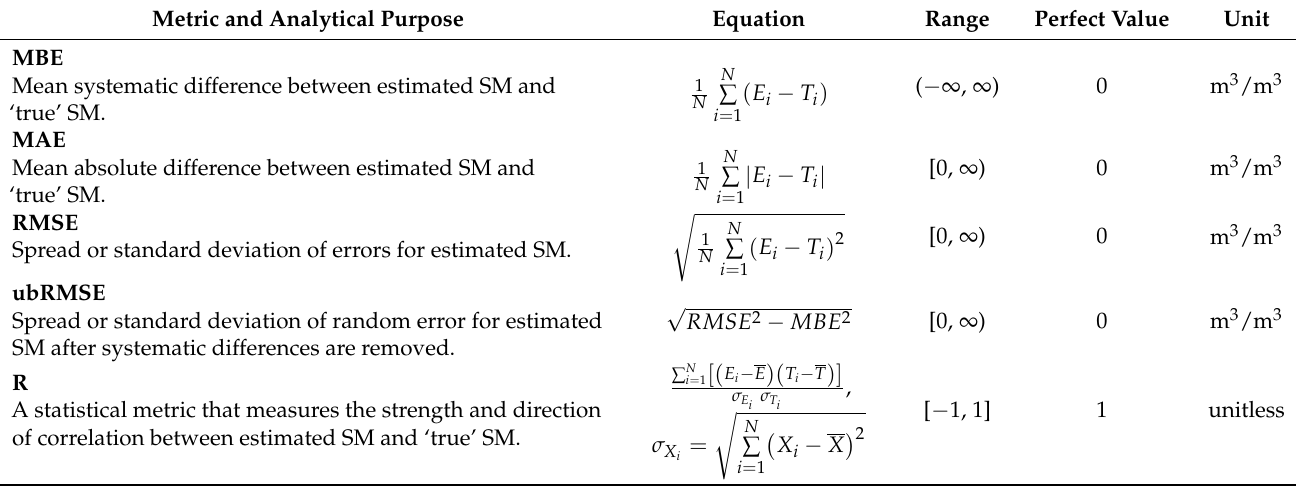
Table 2. Summary of the validation metrics used in the point-based and gridded SM